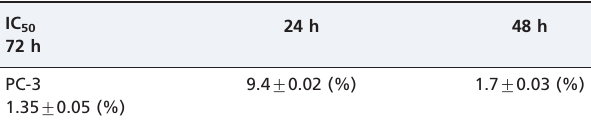
Table 1 - Doses of honey extract that inhibited cell growth by 50% (IC 50 ) in the prostate cancer cell line